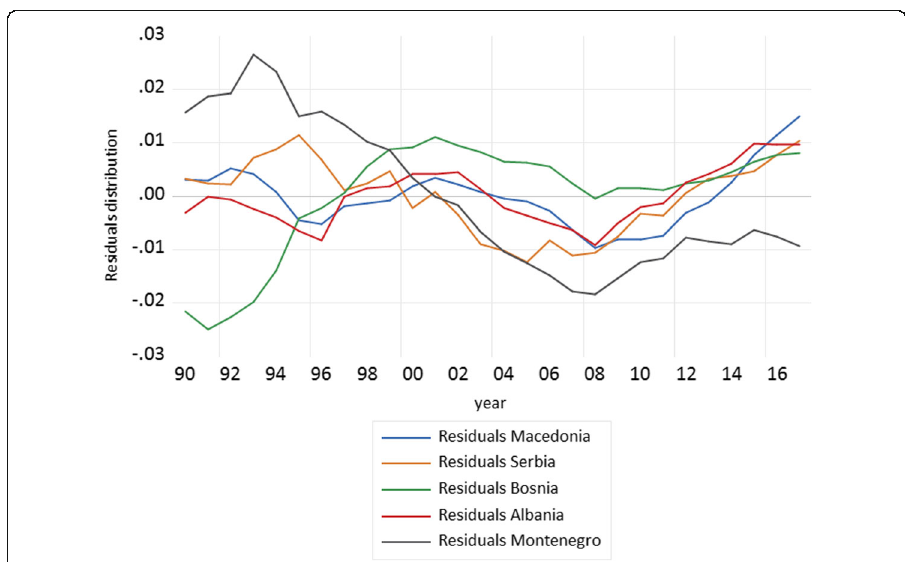
Fig. 4 Residuals graph for the EU accession candidate countries: 1990 – 2017: Residuals graph for the EU accession candidate countries: 1990-2017. Source: Author's design in Eviews 11